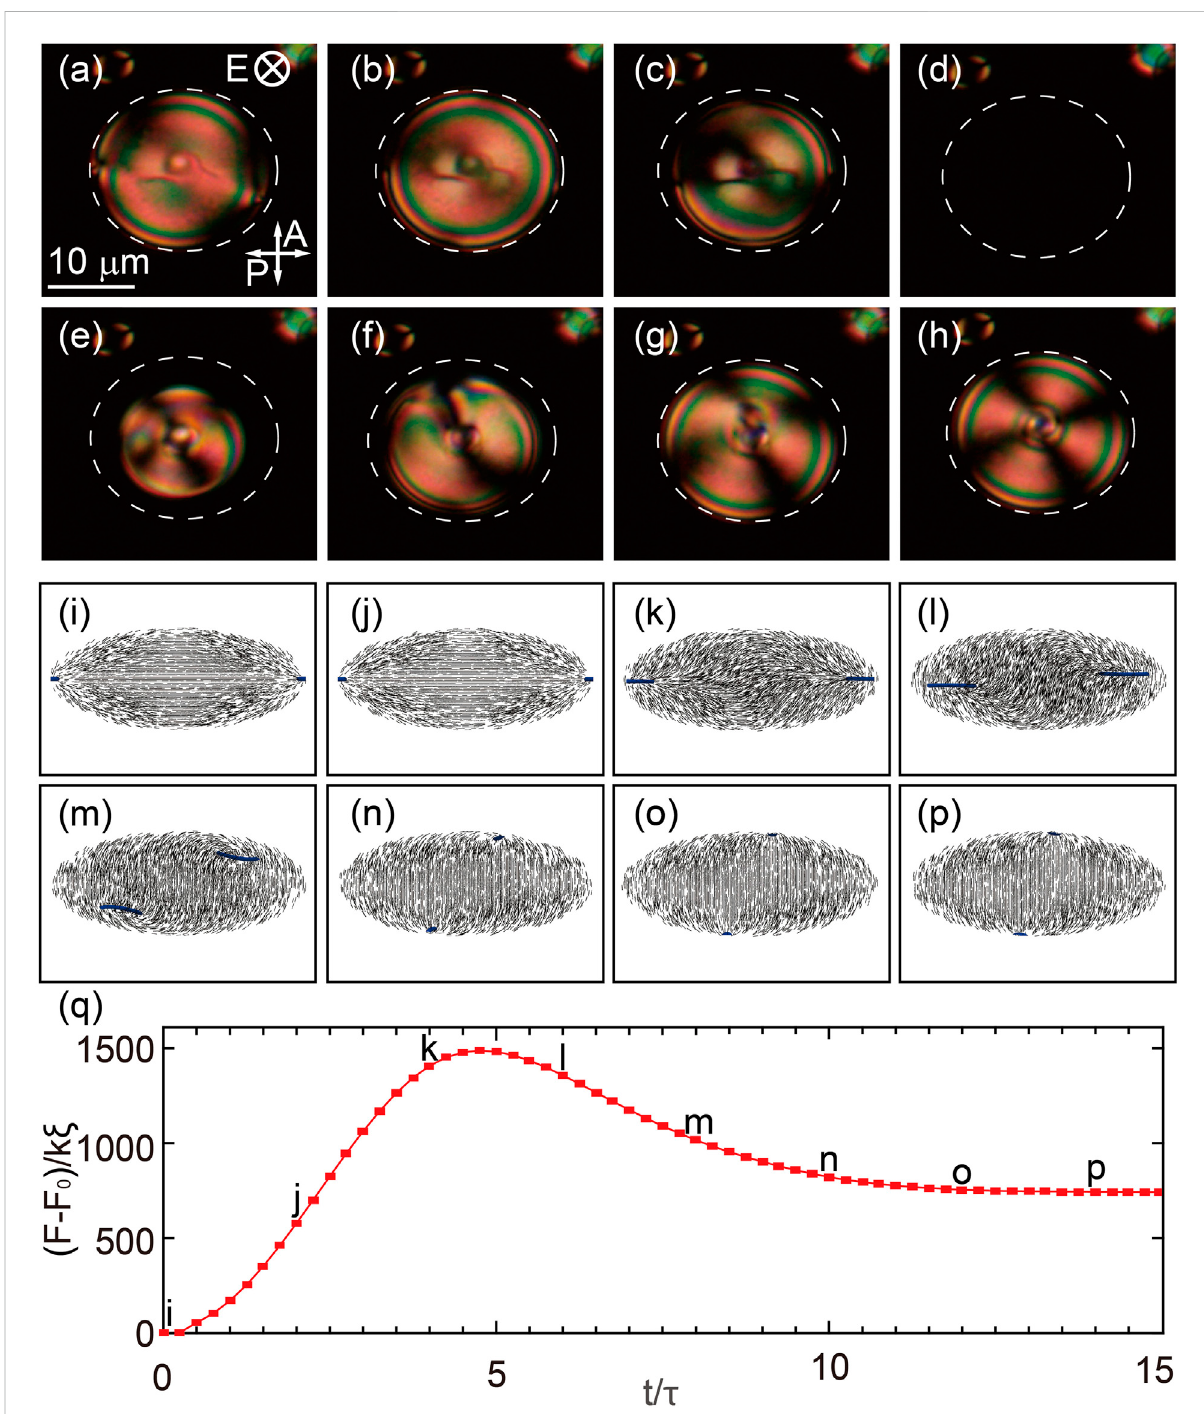
FIGURE 4 ReorientationdynamicsofoblatenematicspheroidunderathresholdE fi eld. (A – H) AsequenceofPOMsnapshotsshowingthereorientationof an oblate bipolar spheroid from the horizontal con fi guration to the vertical con fi guration under E F . Under E F , Fréedericksz transition occurs with mostLCmoleculesalignedalongEandtheopticaltexturebeingessentiallydark.Then,thebipolaraxisreorientsalongtheverticaldirection,showing four dark brushes. The time interval of the snapshots is 4s (I – P) The switching process is also captured by the continuum simulations. FréedericksztransitionoccurswithmostLCmoleculesalignedalongE,whenEreachesE F .Thetwodisclinationsthenmovetothetopandbottomof the oblate spheroid, respectively. (Q) The free energy difference during the switching process, suggesting that the bipolar structure is trapped in a local minimum of the vertical con fi guration after removing E F